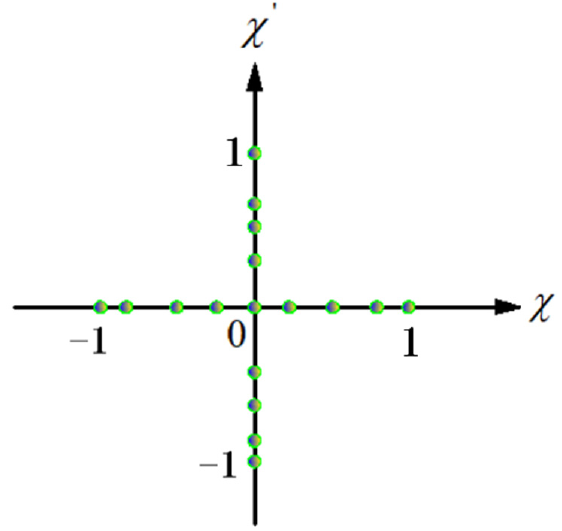
Figure 2. The schematic diagrams of independent variables distribution on the coordinate axis. This method can be applied to calculate the asymmetry coefficient of independent variables such as distance, length and volume, etc. In special cases, researchers can specify the center of symmetry. Generally speaking, for the dependent variable or random function, the value of each function is not completely distributed on the coordinate axis in the space. With the two- dimensional space taken as an example, the schematic diagrams of dependent variables distribution is shown in Figure 3.